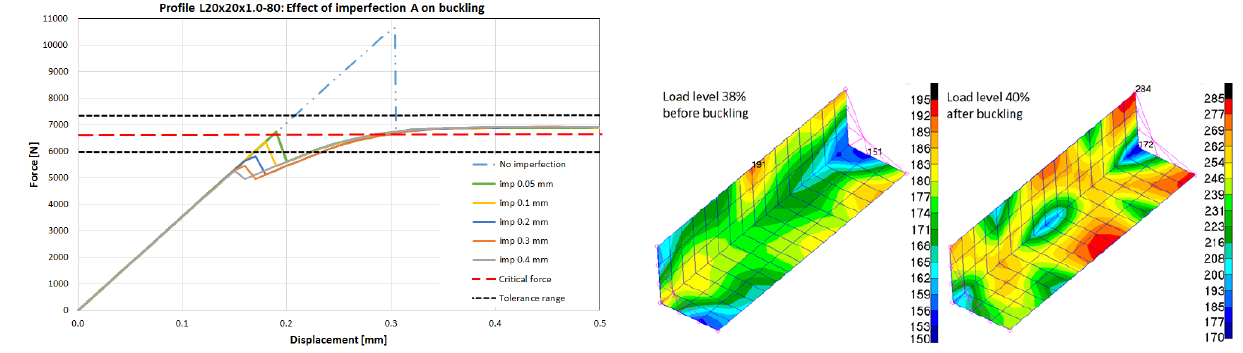
Figure 2. Graphic comparison of force distributions per model displacement